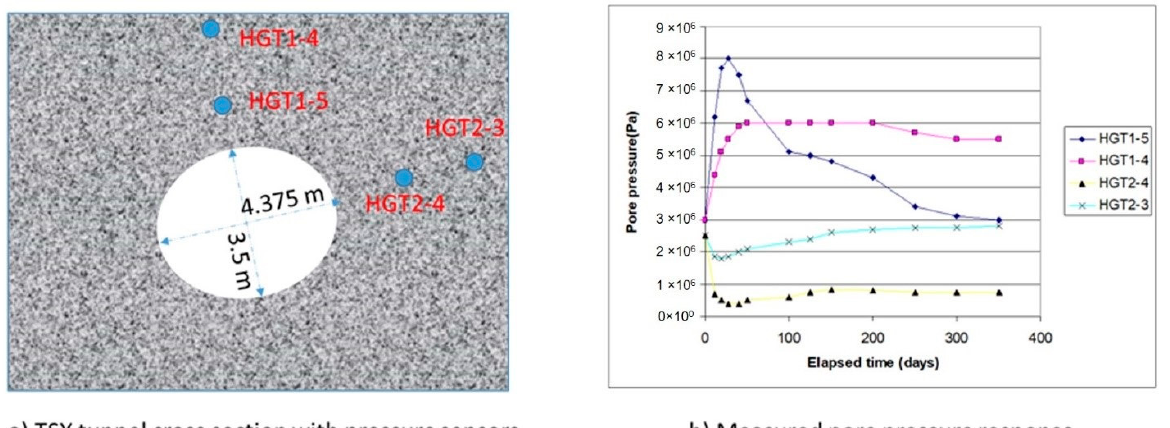
Figure 12. Pore pressure response of the rock mass due to excavation of the TSX tunnel (adapted from Chandler et al. [42]). ( a ) TSX tunnel with pressure sensors. HGT1-5 and HGT2-4 are 1.5 m into the rock; HGT1-4 and HGT2-3 are at 4 m. ( b ) Measured pore pressure response. pore pressure increases in the roof area (HGT1-5 and HGT1-4) and decreases in the side area (HGT2-4 and